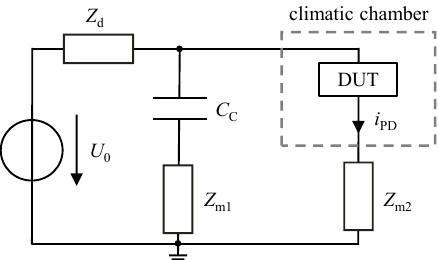
Fig. 1. PD measuring circuit according to IEC 60270 to determine the PD inception voltage and to capture the pulse